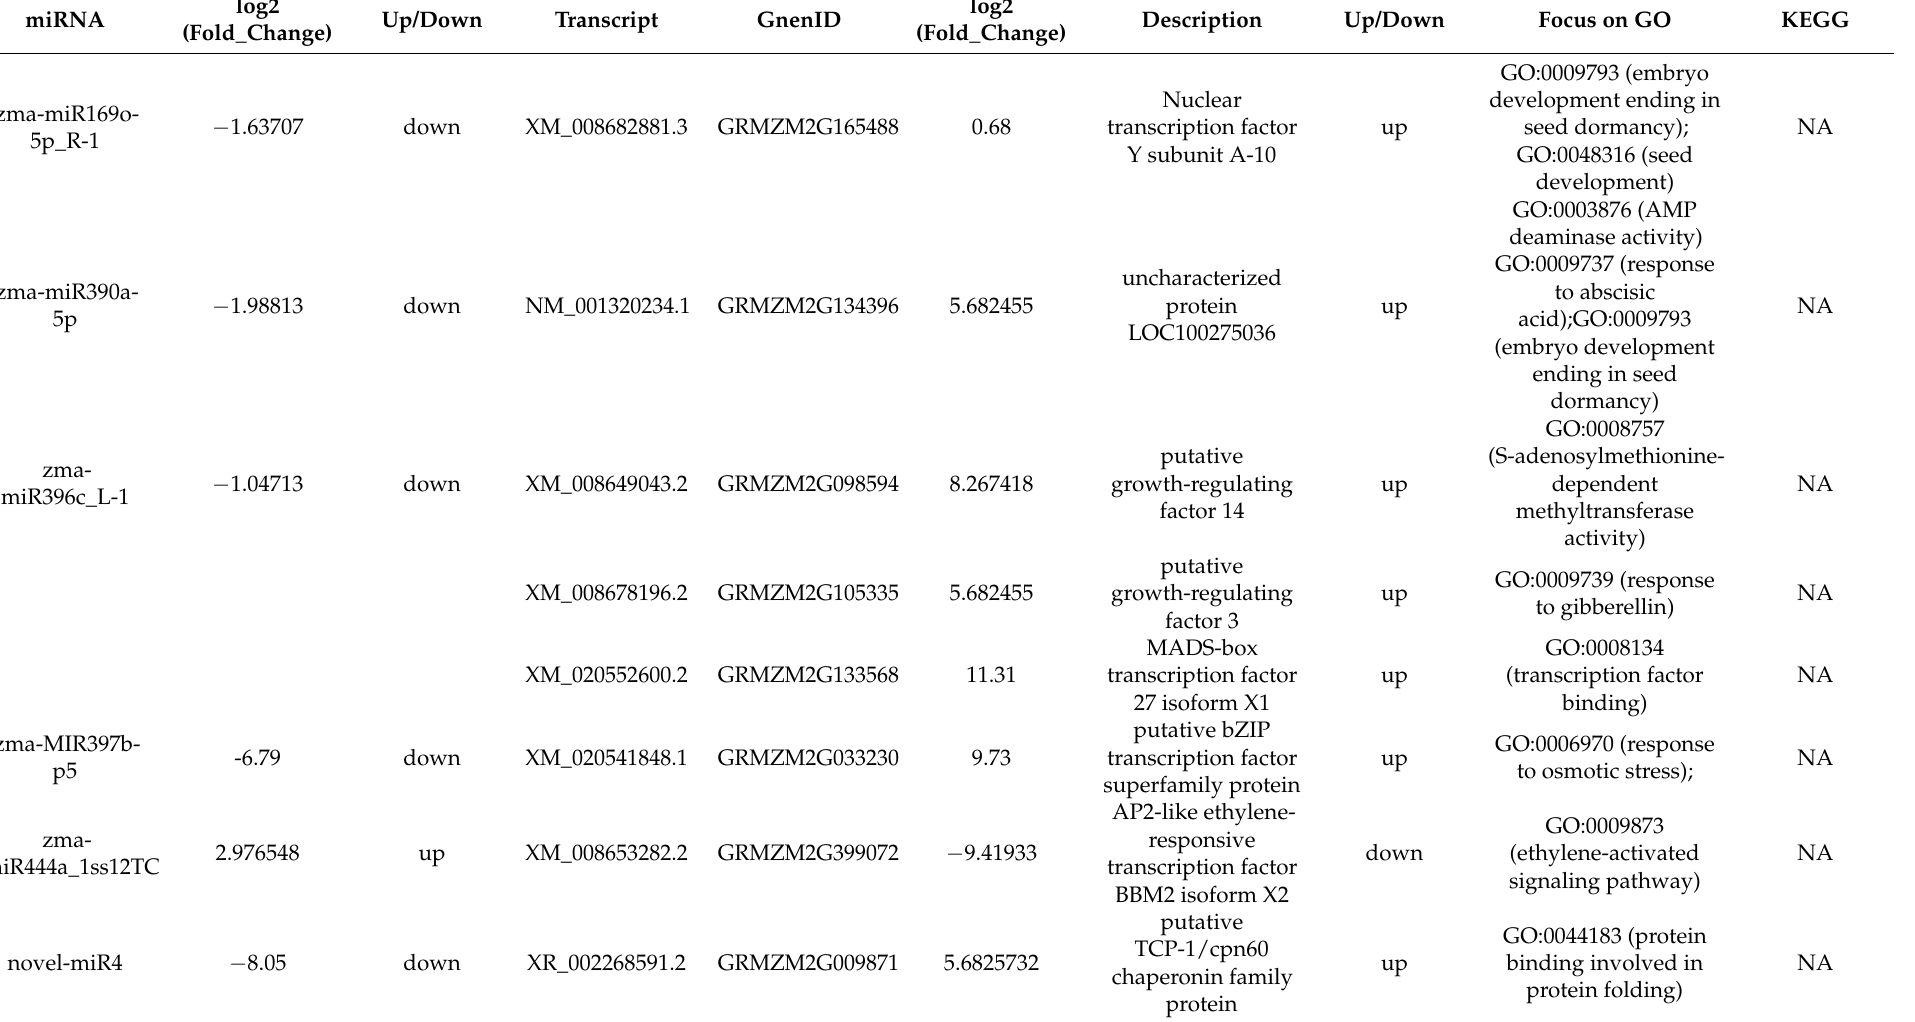
Table 2. Transcriptome–small RNA–degradation group combined